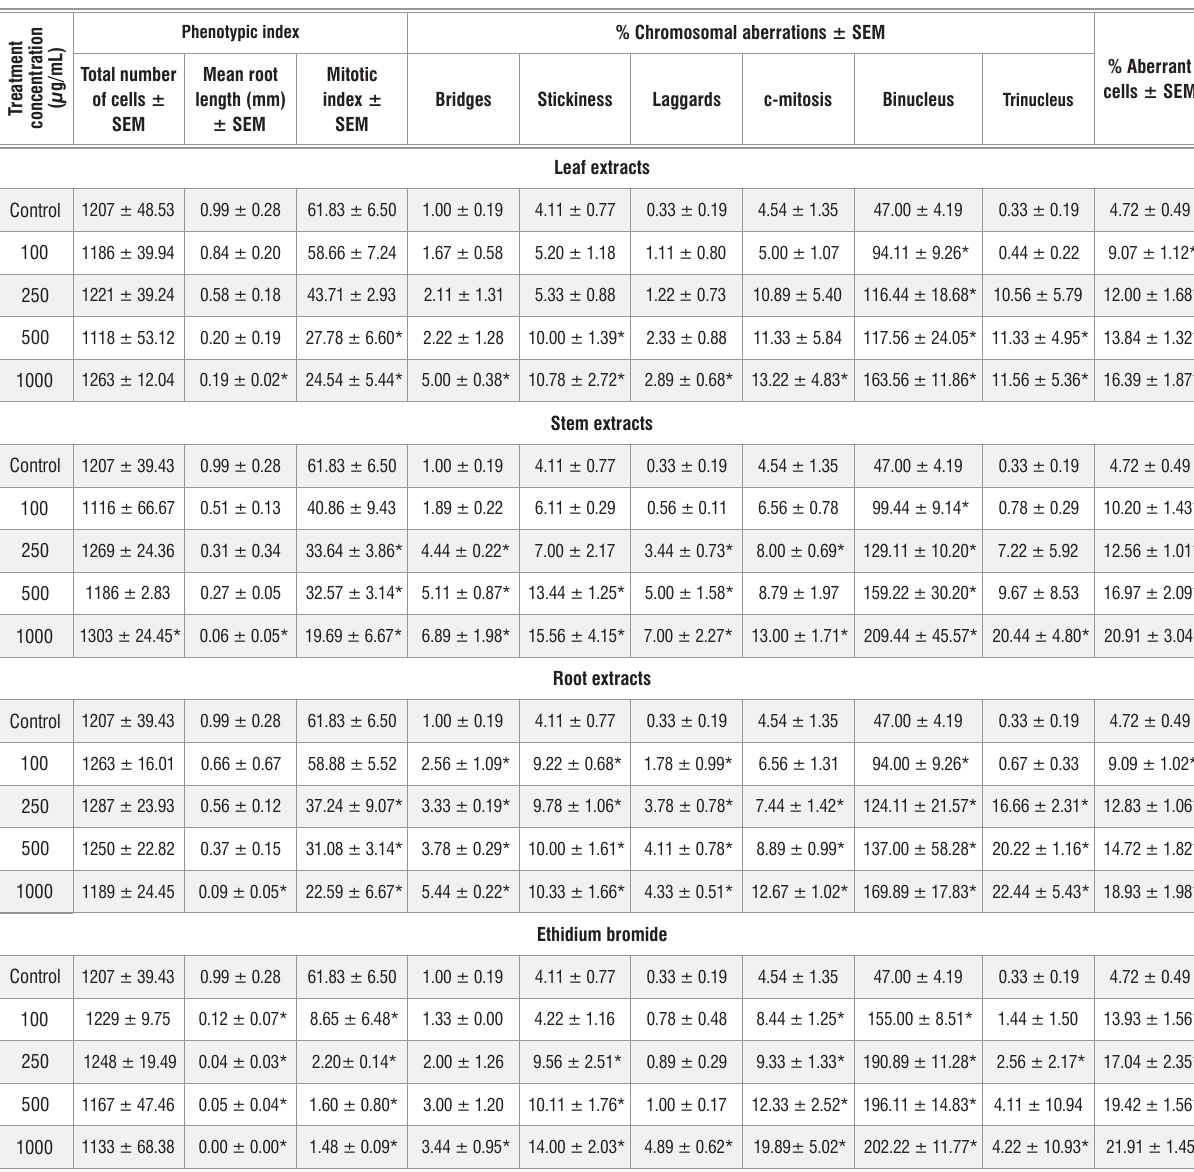
Table 1: Effects of different concentrations of leaf, stem and root extracts of Tulbaghia violacea on root length, mitotic indices and chromosomes in Allium cepa roots